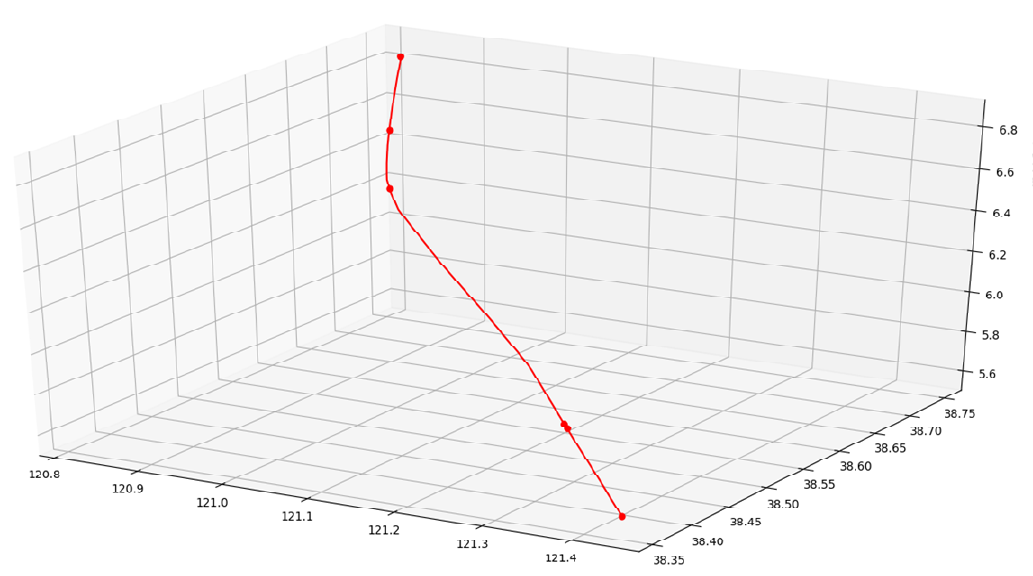
Figure 9. The key feature-points (KFPs) extracted from the single ship.